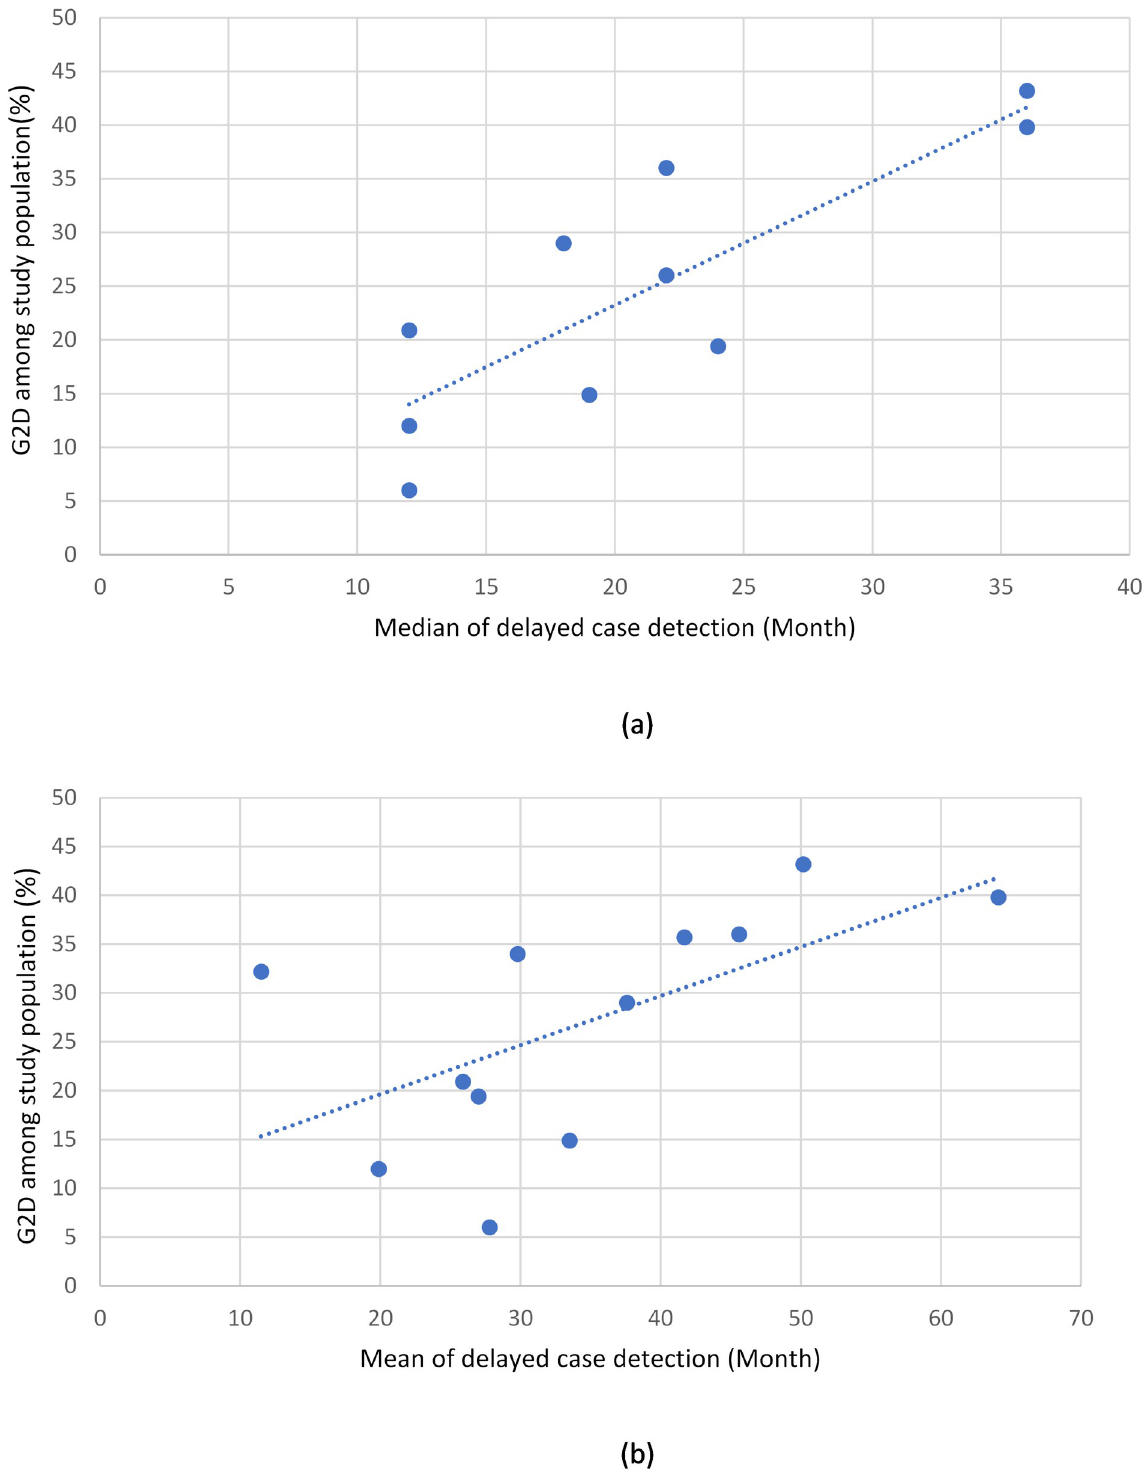
Fig 3. Correlation between (a) median time of delayed case detection and percentage of G2D and (b) mean time of delayed case detection and percentage of G2D.